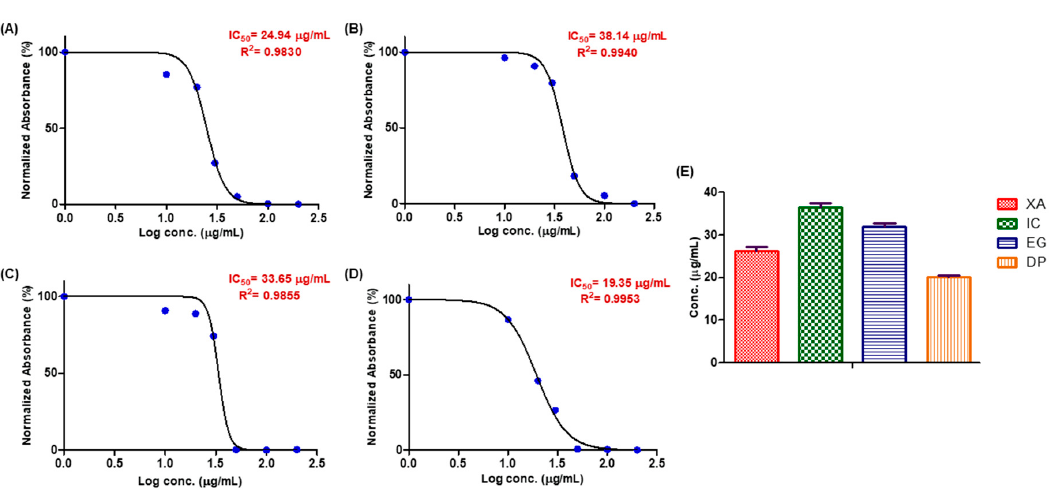
Figure 2. SRB assay on HEK293 cells to evaluate the effect of the four plant extracts: ( A ) XA, ( B ) IC, ( C ) EG and ( D ) DP on the cell growth after 48 h (X-axis: log concentrations of extracts from 1 to 200 (µg/mL) and Y-axis: the percentage of normalized absorbance). Values are mean ± SD of three independent experiments.